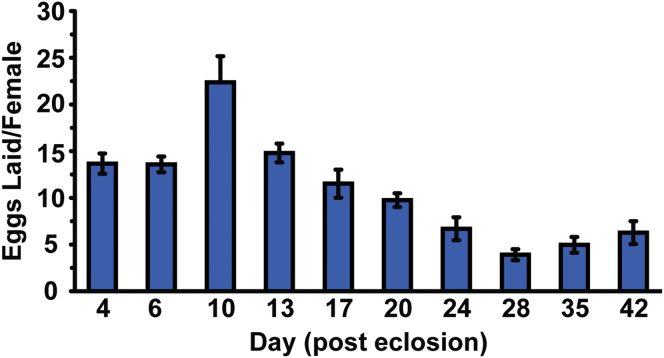
Egg Laying Over Time in wDah Females, Related to Figure 5Egg-laying in wDah females peaks at around day 10 post-mating and then declines to plateau by day 28. Means ± SEM.